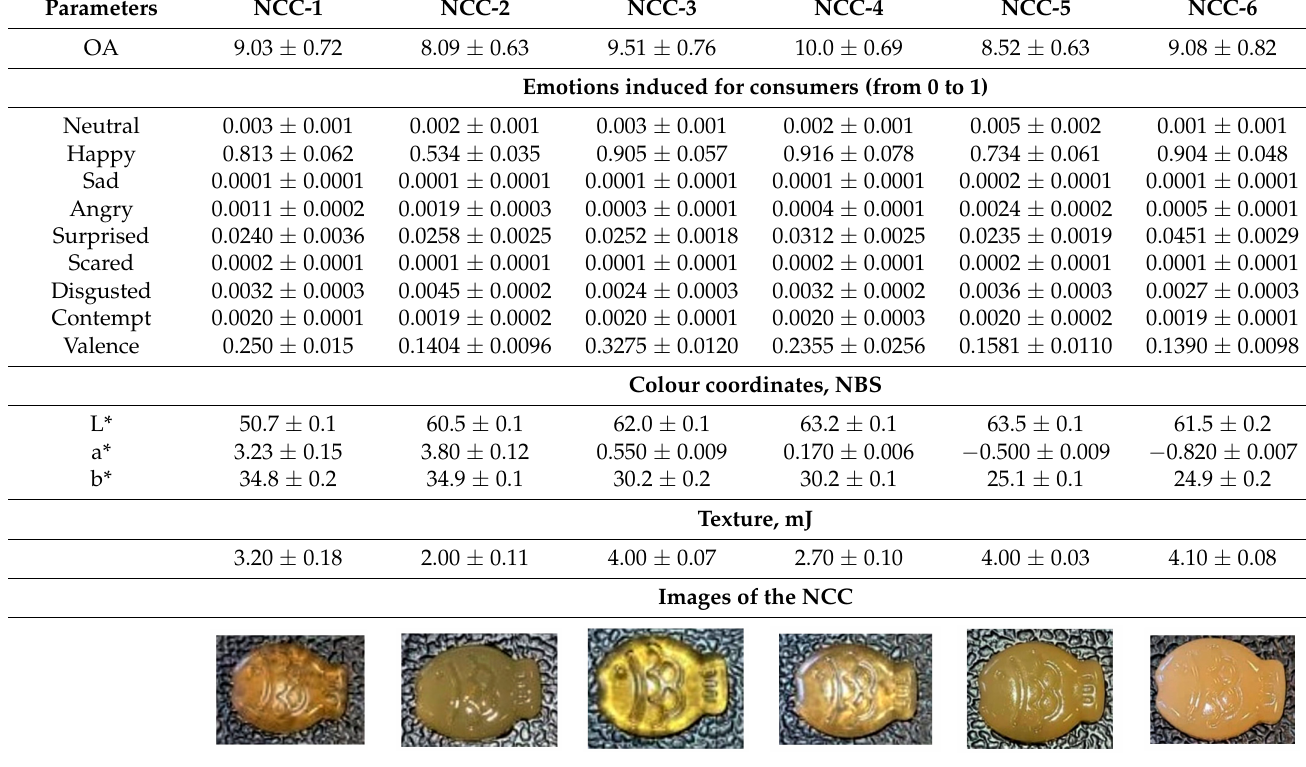
Table 14. Characteristics of nutraceutical chewing